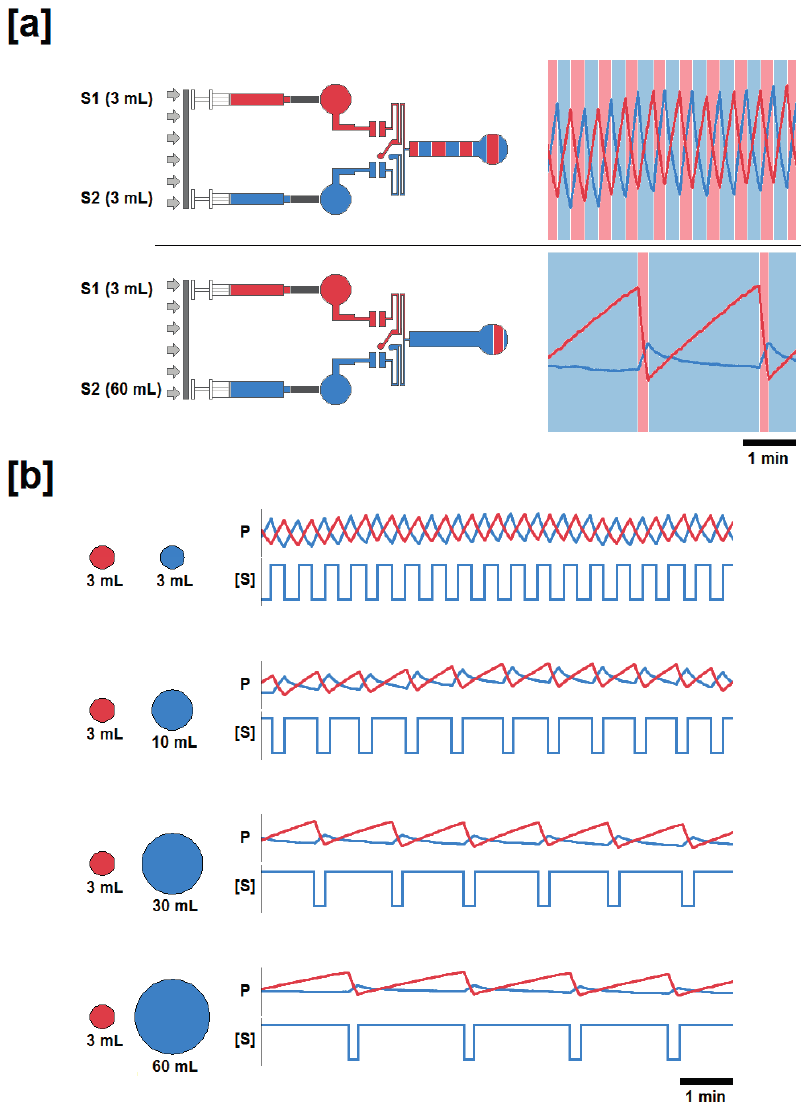
Figure 2. Schematic for the experimental generation of symmetric and asymmetric volumetric flow rates, and changes in duty cycle and pressure profile produced as a function of syringe diameter. ( a ) Two sample conditions where Syringe 1 , (red), and Syringe 2 , (blue), are mounted on a single syringe pump. The ratios illustrated are the symmetric 3 mL:3 mL (upper) and asymmetric 3 mL:60 mL (lower). Within the experimental protocol , Syringe 1 was held constant in all pairings while Syringe 2 was varied to achieve symmetric (50%) and asymmetric (>50%) duty cycles; and total volumetric inflow rate remained constant. Experimentally generated pressure profile waveforms are presented against alternating background bands representing the fluid outflow profile. ( b ) Pressure profile and stimulation period for the four inflow ratio regimes. Pressure profiles were generated while the syringe pump was moving at a constant linear velocity such that the total volumetric inflow rate (the sum of the inflows supplied by each syringe) was maintained at a volumetric flow rate of 20 μ L/min. The pressure profiles recorded ( P ) are presented above each trace representing the concentration of a fluidic stimulant ([ S ]) provided via Syringe 2 , in the